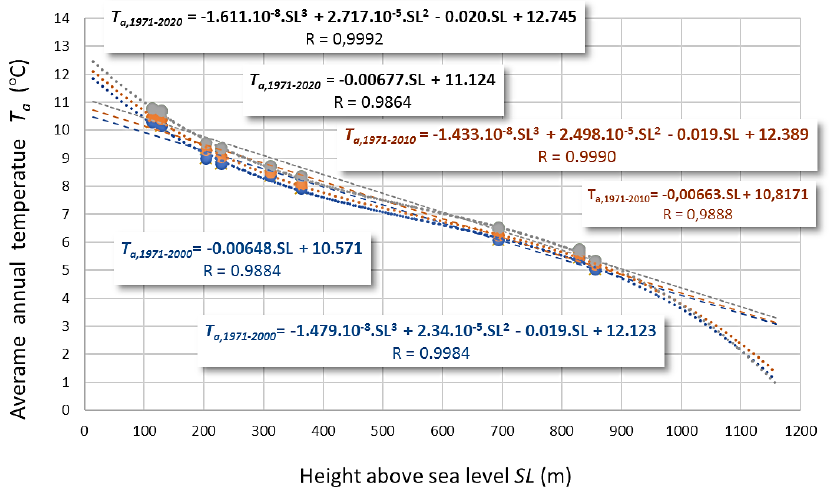
Figure 6. Linear and polynomic correlation dependences of average annual temperatures T a on the altitude of the designed pavement evaluated for the periods of 1971 – 2000, 1971 – 2010, and 1971